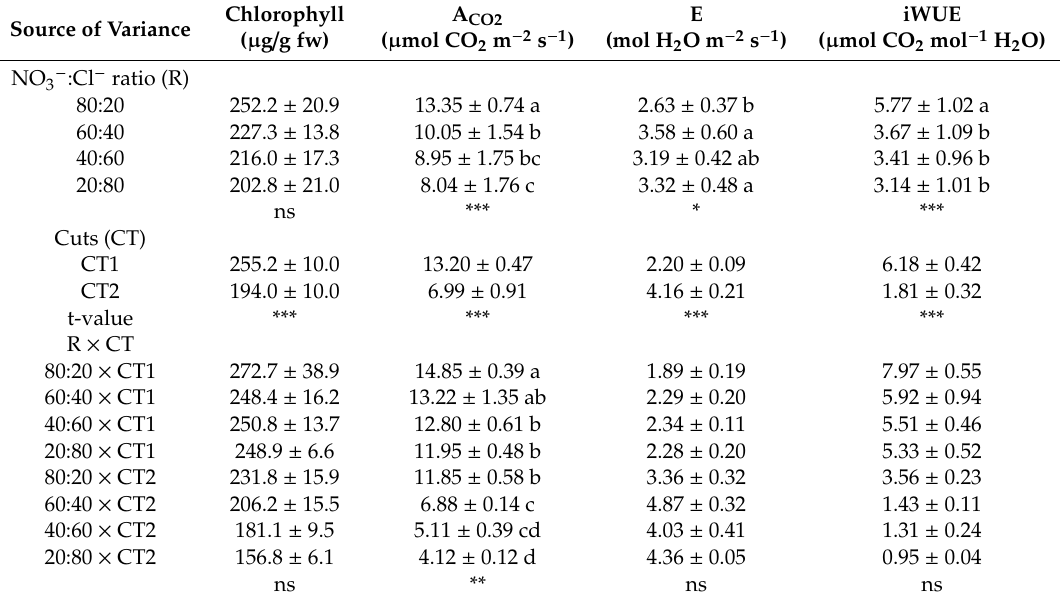
Table 2. Analysis of variance and mean comparisons for chlorophyll content and leaf gas exchange parameters of greenhouse basil cultivated under four NO 3 − :Cl − ratios in the nutrient solution and harvested in two successive